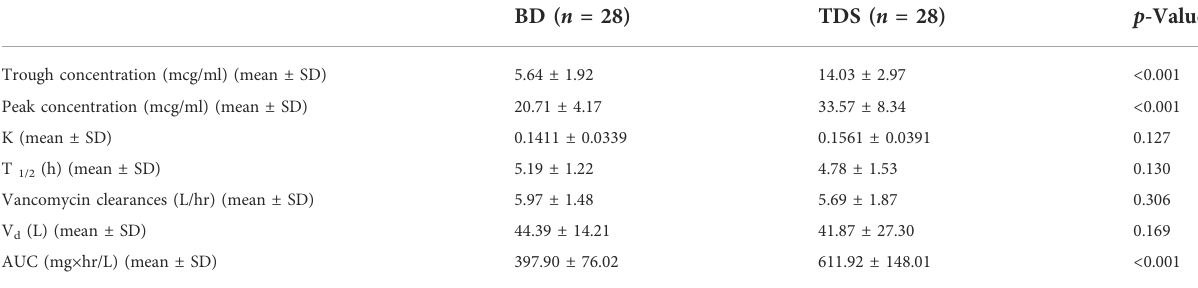
TABLE 4 Calculated pharmacokinetic parameters.